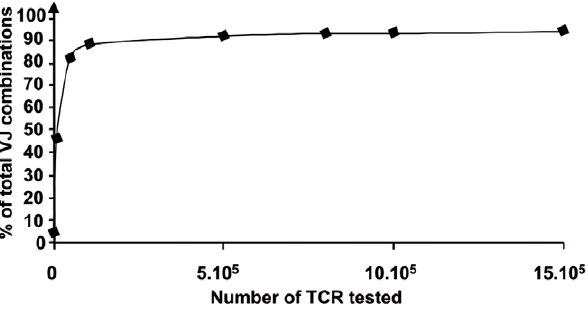
Figure 6. Combinational diversity of V-J combinations and population size. X axis represents the number of TR tested in the simulation, and Y axis indicates the percentage of the number of the different V-J combinations obtained by the simulation over the total number of possible V-J combinations.